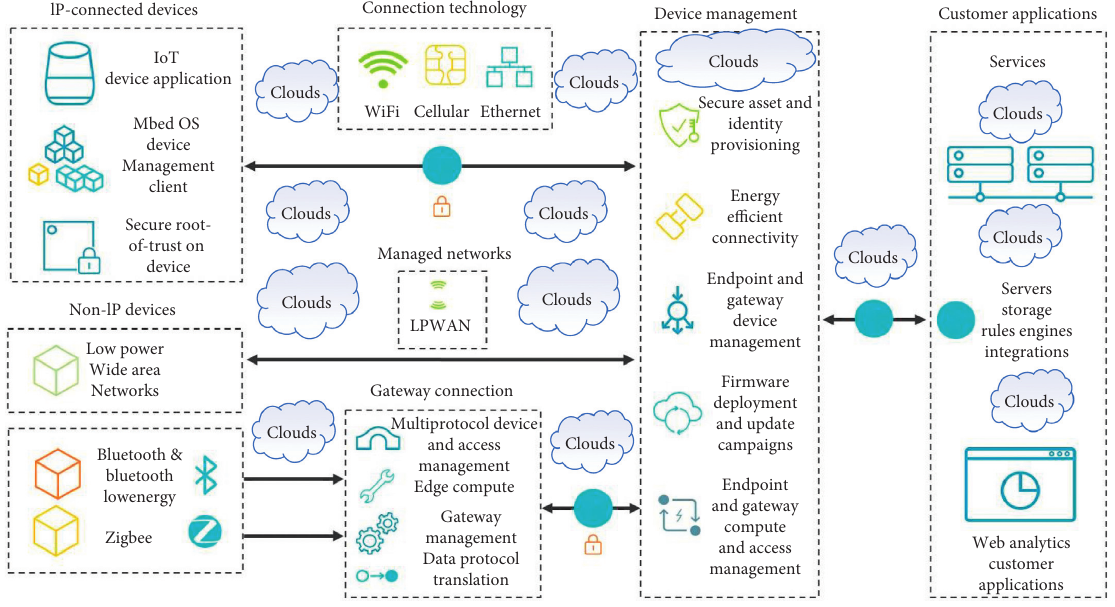
Figure 1: MDM-IoT structure